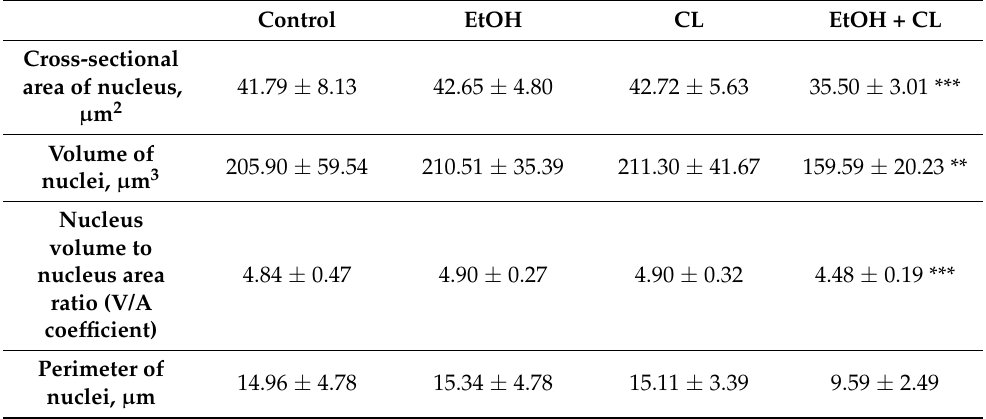
Table 1. Results of the micromorphometric study of hepatocytes of